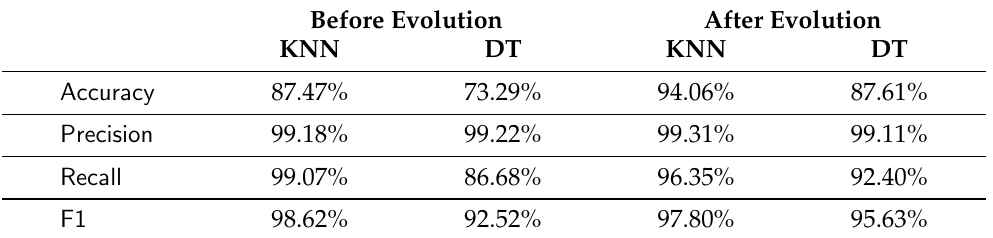
Table 2. Performance for the simple classifiers before and after the evolution of the